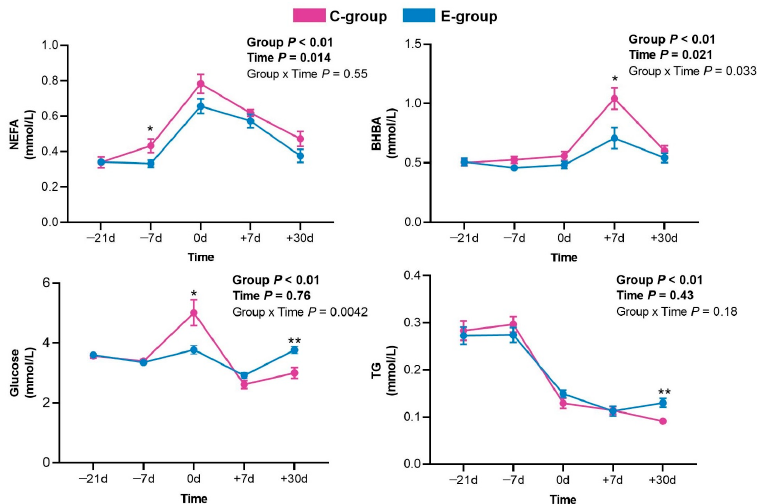
Figure 1. Concentrations of non-esterified fatty acids (NEFA), β -hydroxybutyric acid (BHBA), glucose, and triglyceride (TG) in the exercise (E-group) and control (C-group) groups at − 21 d, − 7 d, 0 d, +7 d, and +30 d relative to calving. Data are expressed as a mean ± SEM; * p < 0.05, ** p < 0.01, comparing the two groups at a given time point.